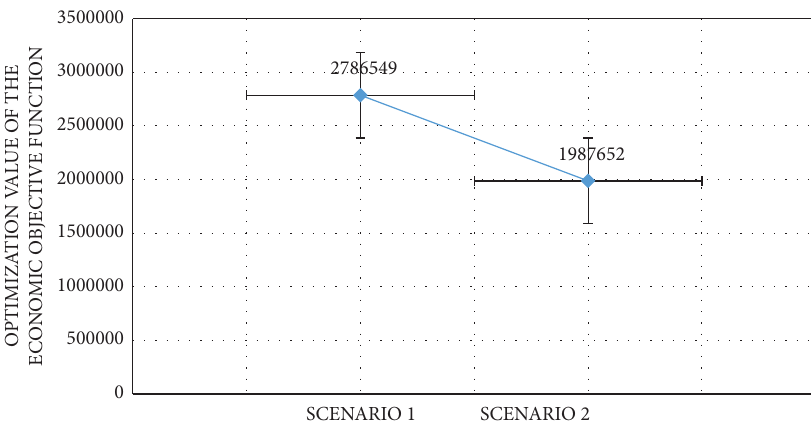
Figure 11: Sensitivity analysis of environmental aspect (normal COVID) models.